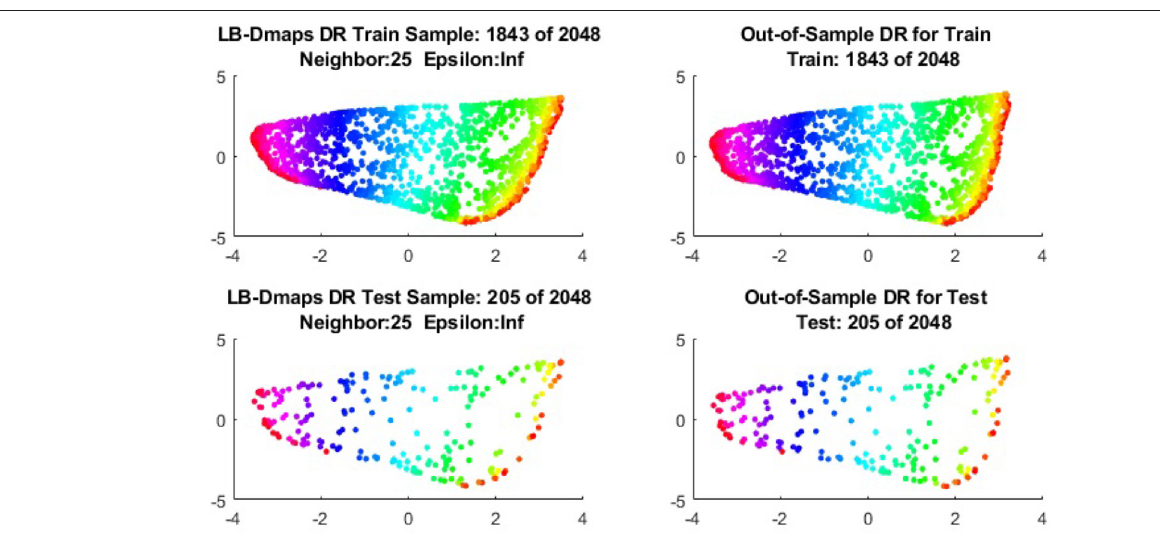
Frontiers in Applied Mathematics and Statistics |